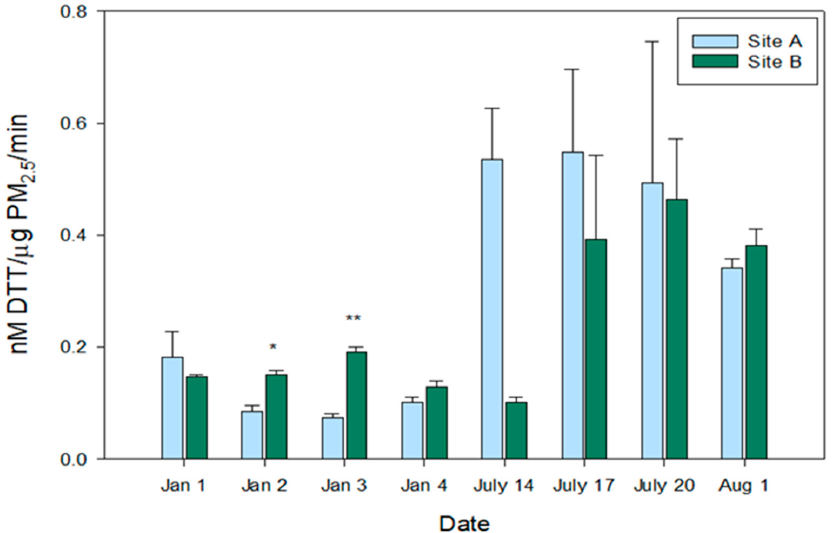
Figure 4. DTT Consumption per PM 2.5 mass per minute. DTT (dithiothreitol) consumption (nM) per PM 2.5 mass ( µ g) per minute of reaction incubation for each sampling day for Sites A and B are reported